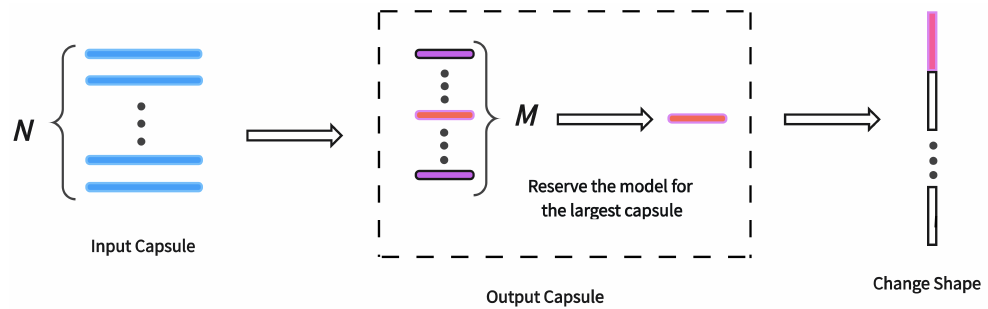
Figure 4. In the routing process of the capsule network, the number of input and output capsules are N and M , respectively; the mask mechanism is used so that the output capsule retains the largest capsule of the model, and the rest of the capsules are all